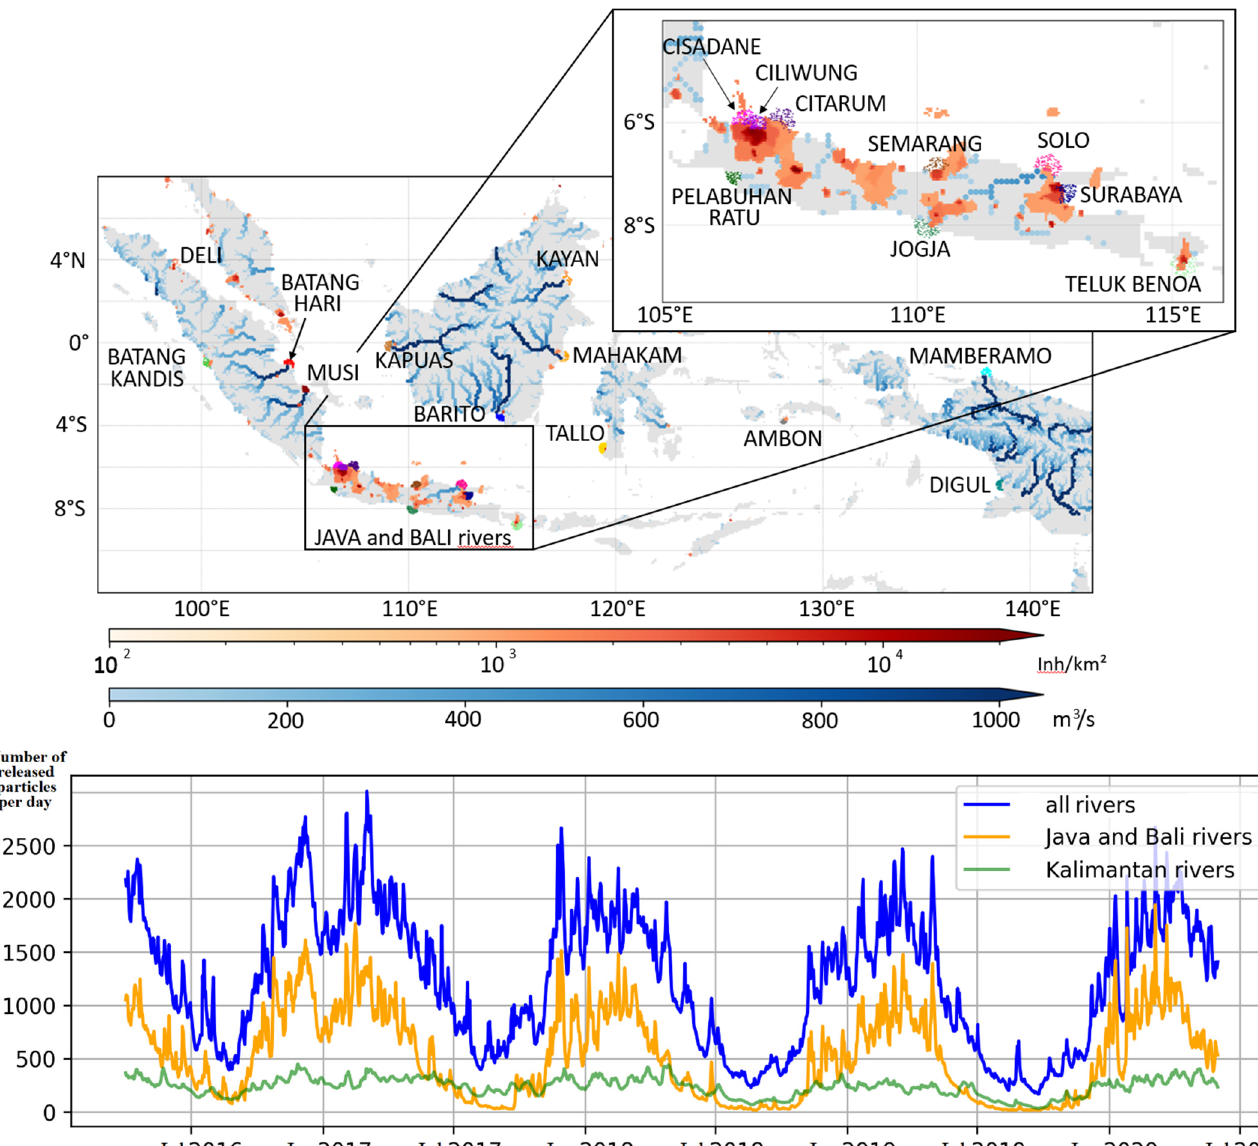
Figure 2. Spatial and temporal characteristics of the source scenario. Upper panel: names and locations of the 21 rivers selected to release particles in the simulation. River discharges [m 3 /s] are indicated in shades of blue and population density [inhabitant/km 2 ] in shades of orange. Colored dots indicate the particle release position on the first day of the simulation. The colors differentiate the riverine origins. See [35] for detailed coordinates of river mouths. Lower panel: time series of the sum of released particles for all 21 rivers (blue line), the 9 rivers of the islands of Java and Bali (orange line) and the 4 rivers from Kalimantan (green line). The daily number of released particles linearly follows the river discharge evolution. This relationship is detailed in Section 2.2.2 on the “river source